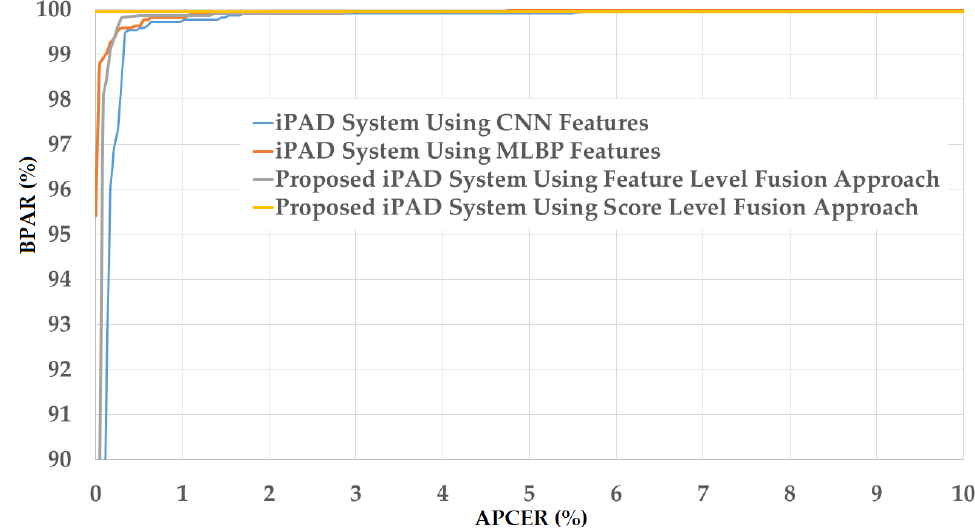
Figure 11. DET curves of iPAD systems based on use of CNN, MLBP, and hybrid image features (feature level fusion and score level fusion approach) using Warsaw2017 test-unknown dataset.